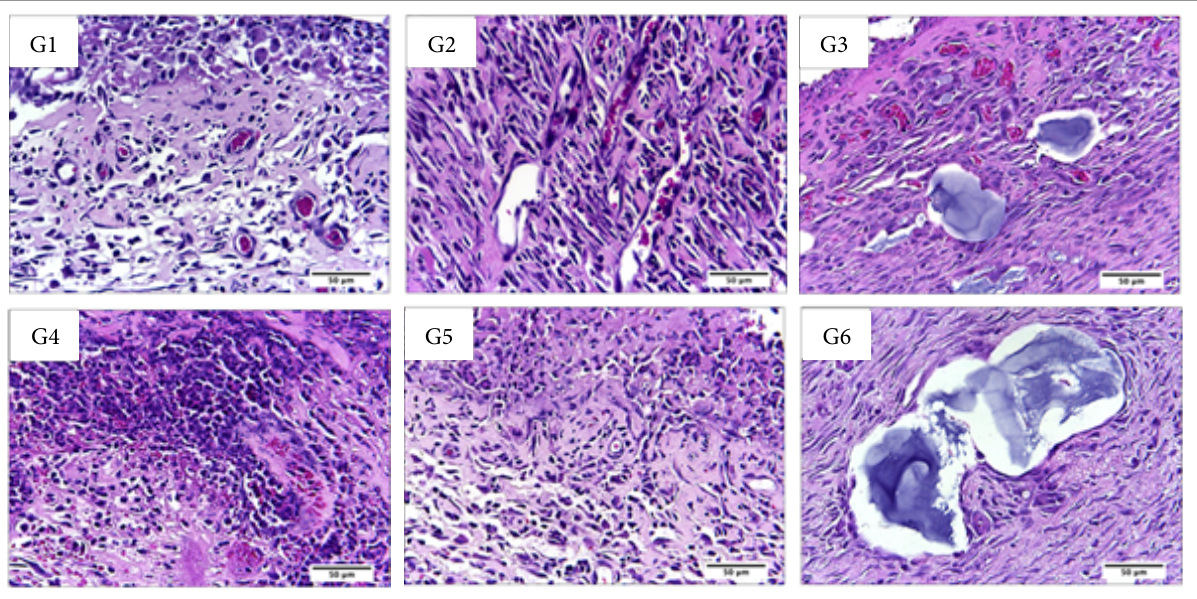
Figure 6 - Microscopic aspects of partial thickness burn wounds experimentally induced in Wistar rats 14 days after the injury induction. Stain hematoxylin and eosin. Augmentation: 10x scale in μ m.